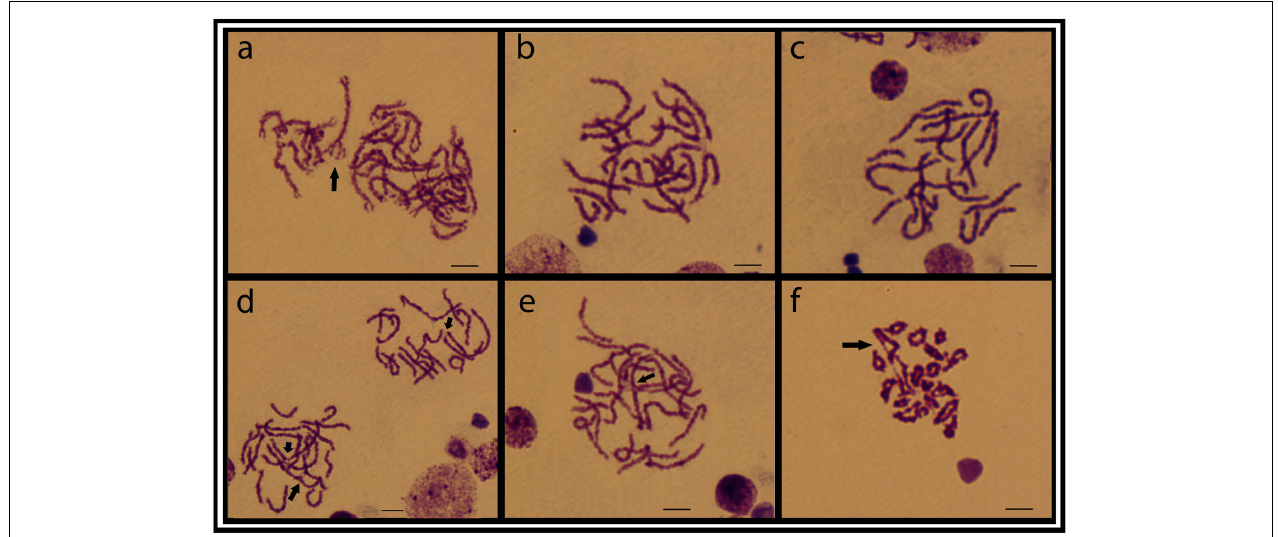
FIGURE 5 | Testicular meiotic cell plates from the ESU-D in Giemsa staining. (a) Zigotene cells, with a possible tetravalent arrangement; (b–e) Aneuploid pachytene cells and arrows evidencing chiasmata formation; (f) Diplotene cells, with associated chromosomes likely in a chromosomal chain organization. Bar = 10 µ m.